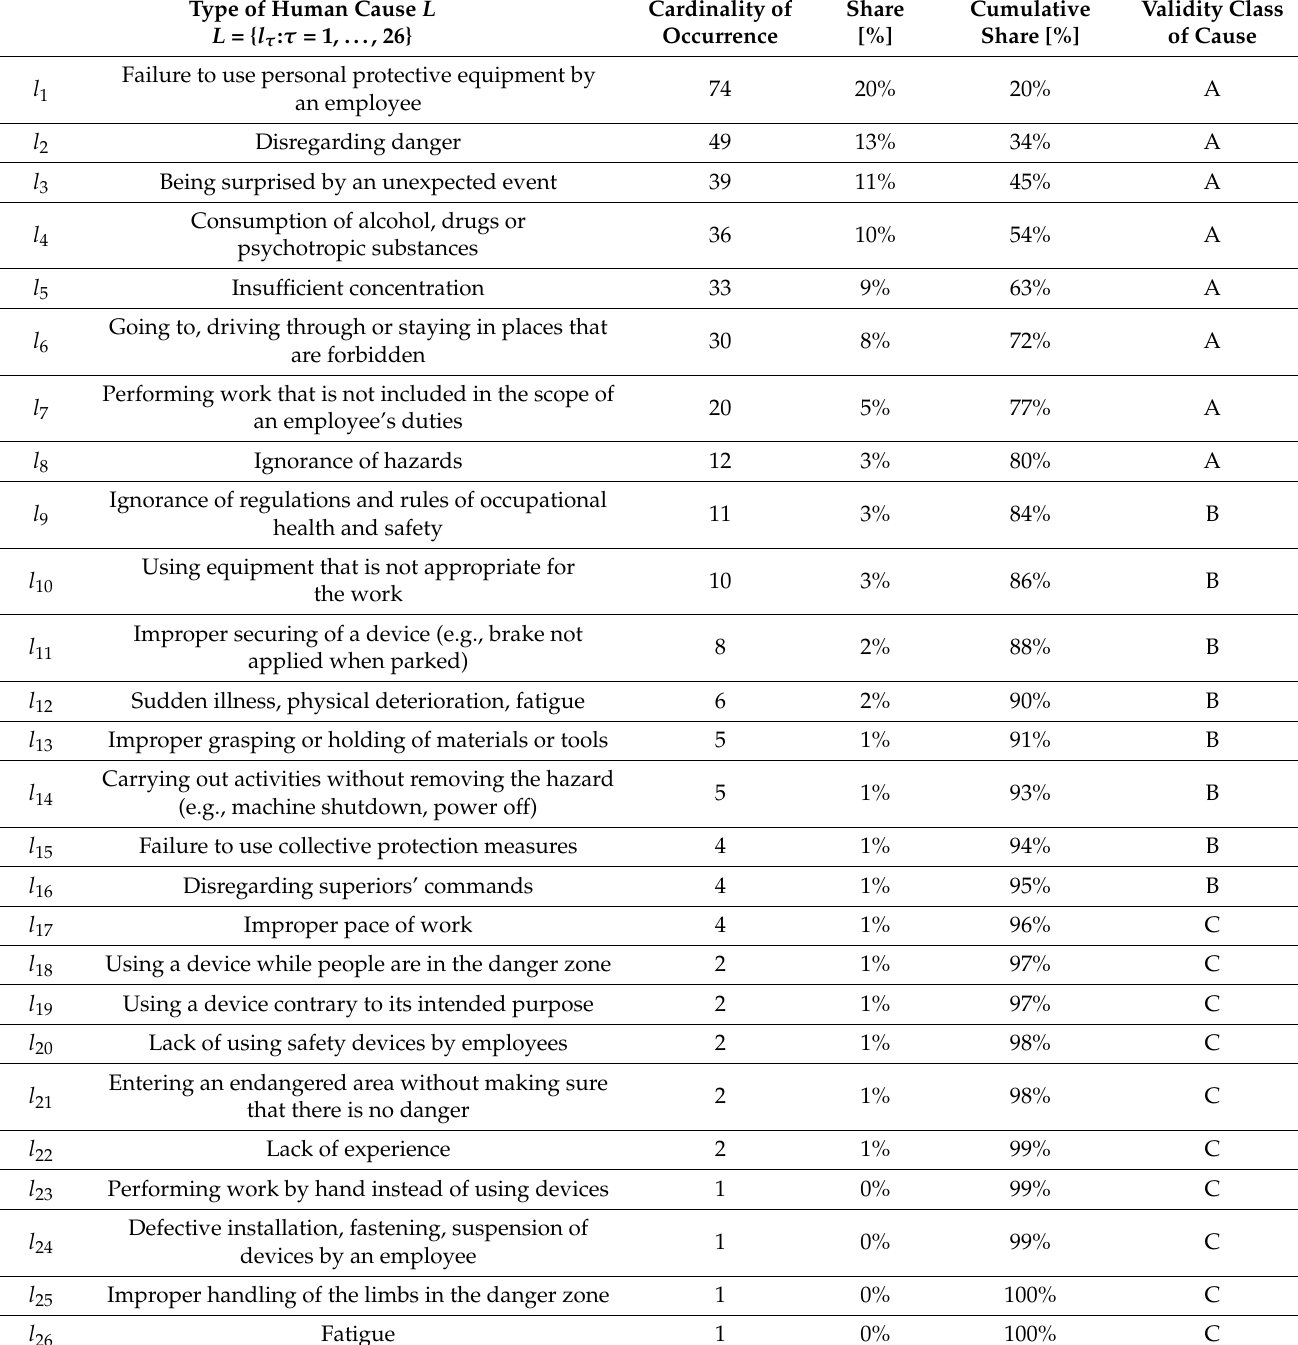
Table 4. Analyzed detailed human l τ